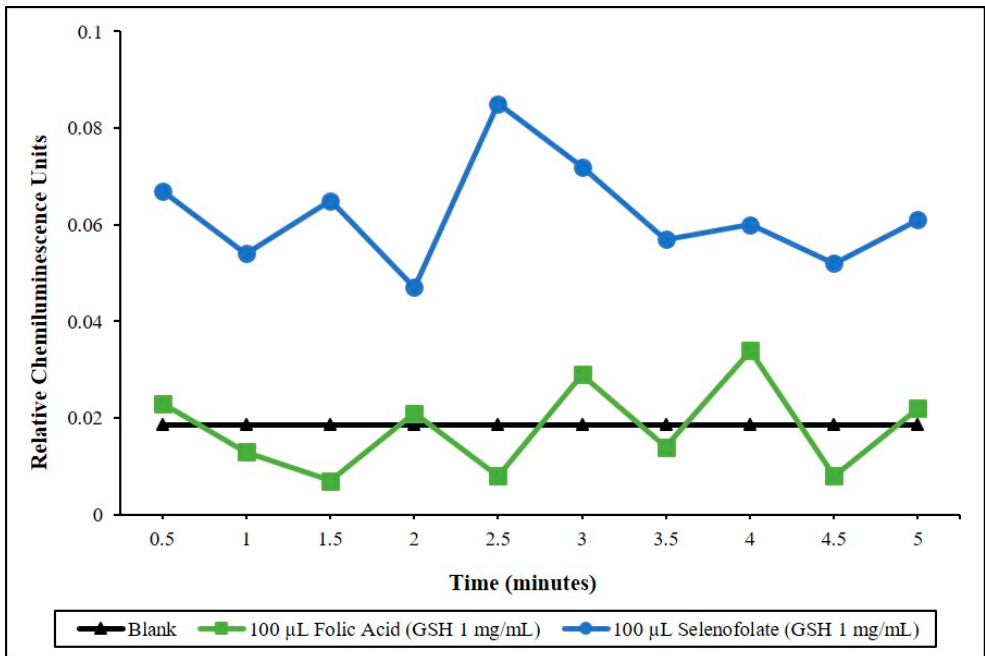
Figure 3. Time dependent superoxide generation as a function of lucigenin chemiluminescence. Chemiluminescence (CL) was measured for blank, Folic Acid and Selenofolate, 100 µL of Selenofolate = 70 µg of Se. Real time (CL) assay in 30 s integrations.